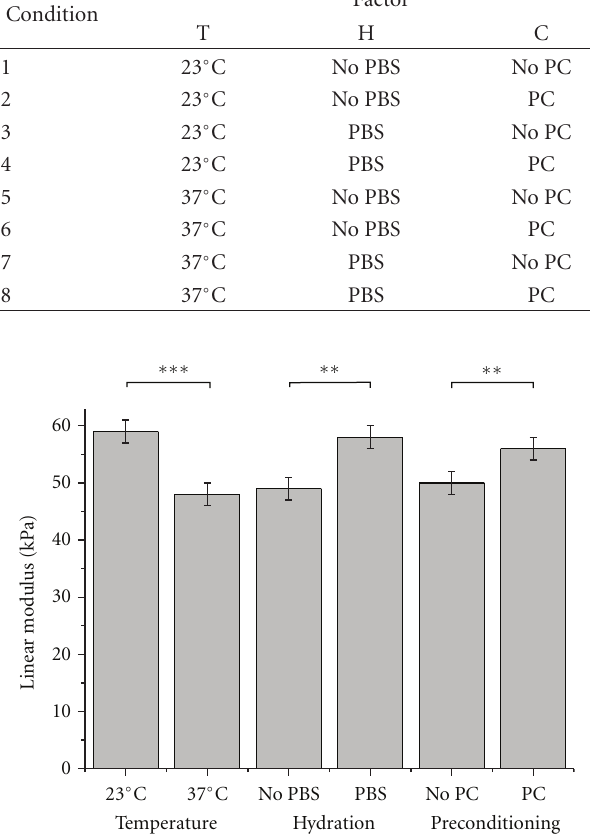
− 0 . Figure 3: Example of a curve obtained from a stress relaxation test on a preconditioned collagen gel in air at 23 ◦ C.